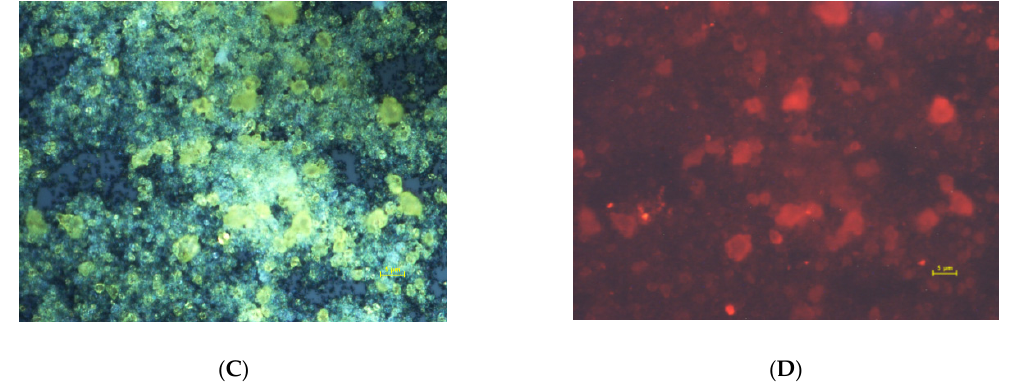
Figure 5. ( A ) The Tauc plot presenting ( α h ν ) 2 vs. h ν dependence based on inset, showing UV ‐ vis spectra obtained for CdS nanoparticles; ( B ) photoluminescence (PL) spectrum of dry CdS nanoparticles drop ‐ cast on a fused silica substrate; ( C ) optical microscopy image under white light; and ( D ) fluorescence microscopy image under 530 nm illumination of CdS NP dropcast on quartz glass. Scale bar is 5 μ m on both C and D.